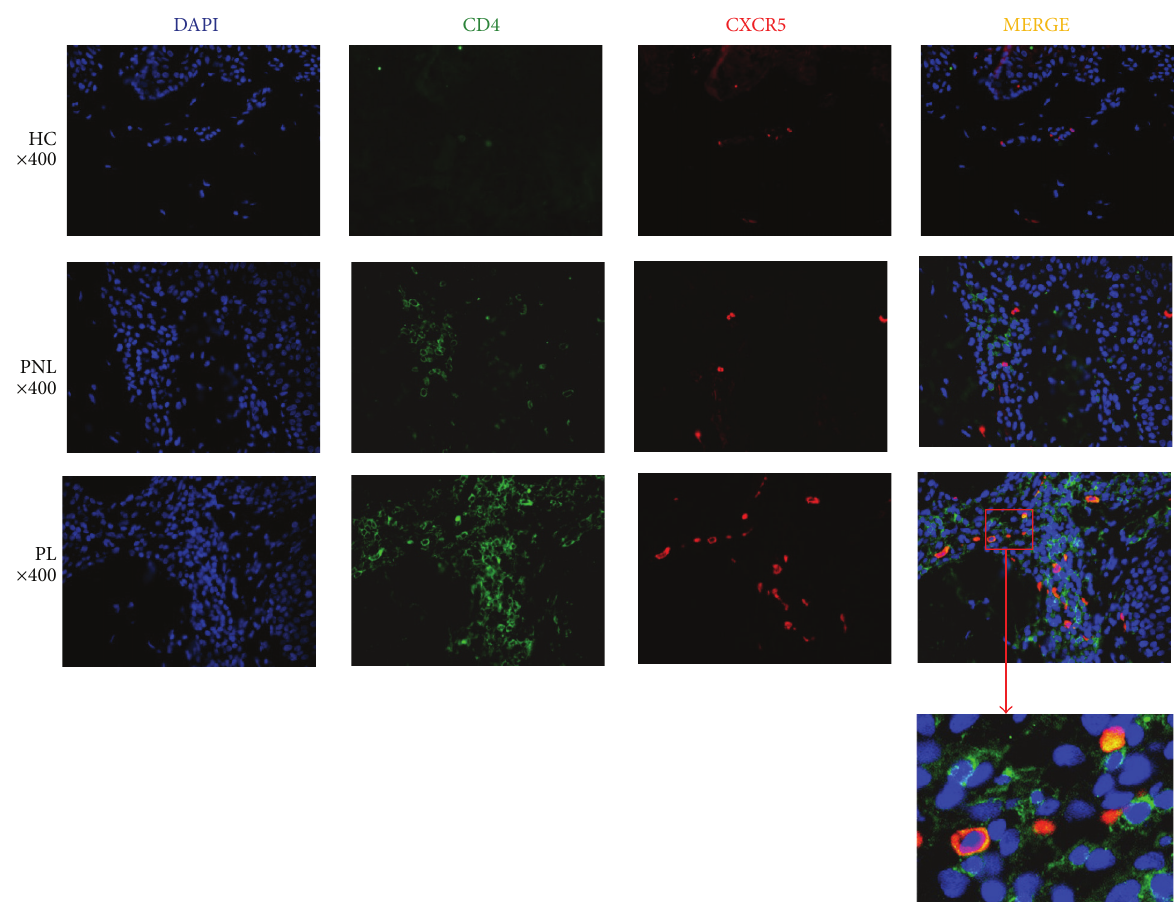
Figure 2: Higher infiltration of Tfh cells in psoriasis lesions. (a) Representative immunohistochemical staining of Tfh in psoriasis lesions (PL), nonlesional skin tissues of psoriasis patients (PNL), and normal skin tissues of healthy controls (HC). Tfh cells are double stained for CD4 (brown, on cell membrane) and CXCR5 (blue, on cell membrane). There are no Tfh cells infiltrated in skin tissues of healthy controls. (b) The number of Tfh cells in psoriasis lesions is significantly increased compared with nonlesional skin tissues of psoriasis patients, which was evaluated quantitatively by 2 independent observers from 3 representative fields (200x). (c) The number of infiltrated Tfh cells in psoriasis lesions is not associated with disease severity, as assessed by psoriasis area severity index (PASI) score. 𝑃 value is shown. (d) Costaining of CD4 and CXCR5 in skin tissues from psoriasis patients and healthy controls by immunofluorescence. Representative staining shows CD4 (green) and CXCR5 (red) cells. DAPI was used to counterstain nuclear DNA (blue). The 2-color merged panels were shown with colocalization visible in yellow. Representative staining at an original magnification of 400x is